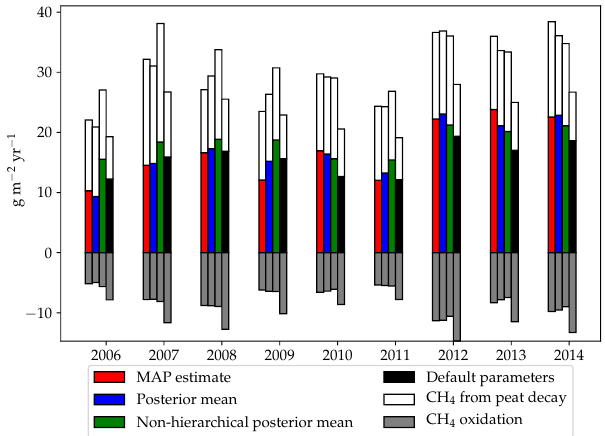
Figure 13. Annual CH 4 production in gm − 2 from root exudates (colored part) and peat decomposition (white part) for the different years. Oxidized CH 4 is shown as gray and